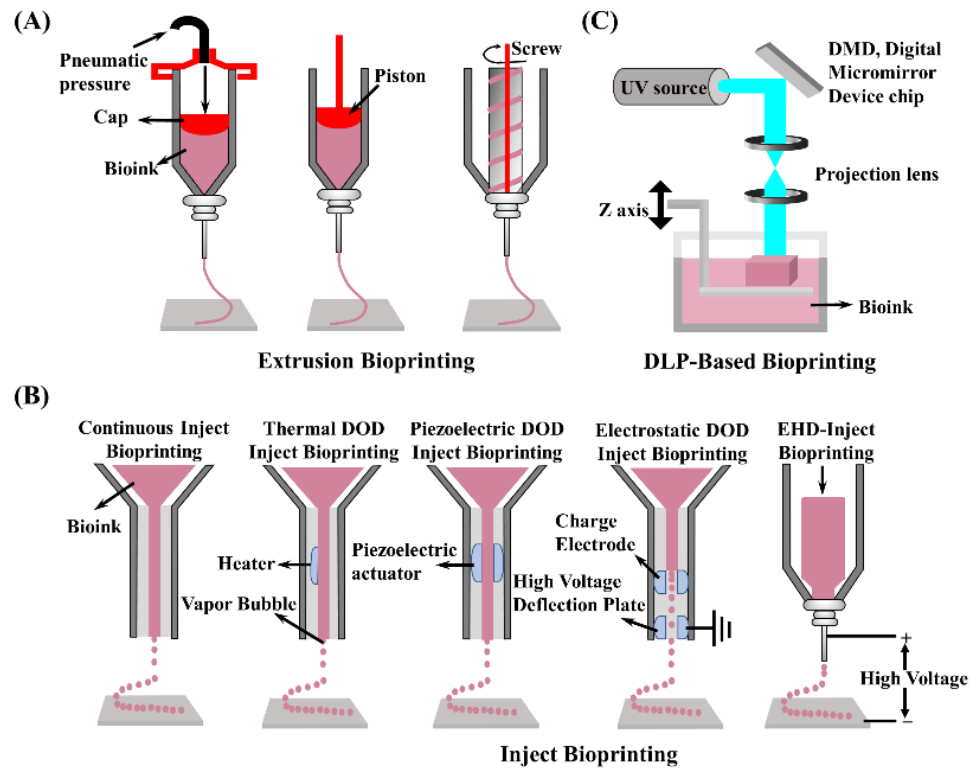
Figure 4. Schematic diagram of three representative 3D bioprinting technology devices: ( A ) extrusion bioprinting; ( B ) inject bioprinting; and ( C ) DLP bioprinting.